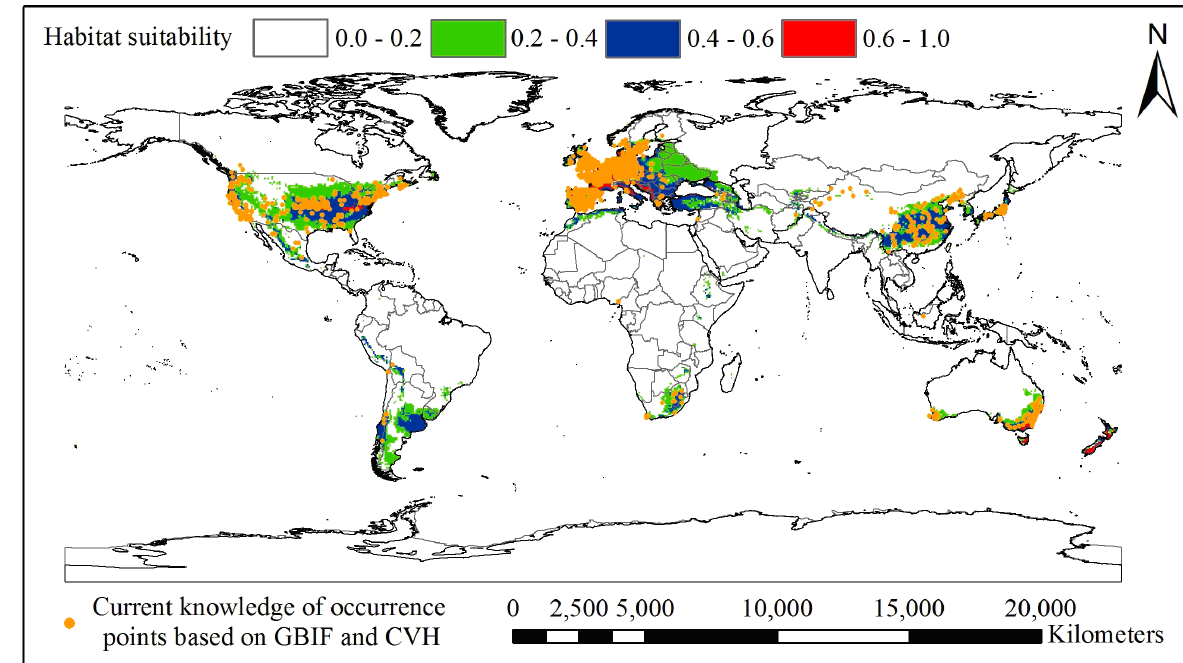
Figure S3. The difference between the current distribution knowledge of GBIF and CVH and the potential distribution of black locust. No occurrence records were found in the following 24 countries: Peru, Uruguay, Brazil, Zimbabwe, Kenya, Ethiopia, Morocco, Algeria, New Zealand, Croatia, Bosnia and Herzegovina, Yugoslavia, Albania, Macedonia, Bulgaria, Turkey, Iran, Azerbaijan, Ukraine, Belarus, Lithuania, Latvia, Estonia and Russia, most of which are developing